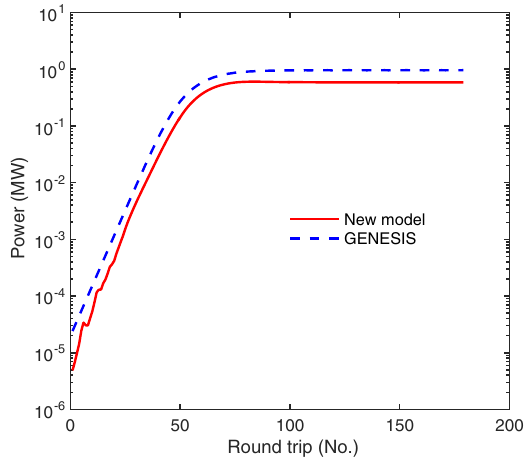
FIG. 9. The enhancement of output laser peak power with various passes N pass